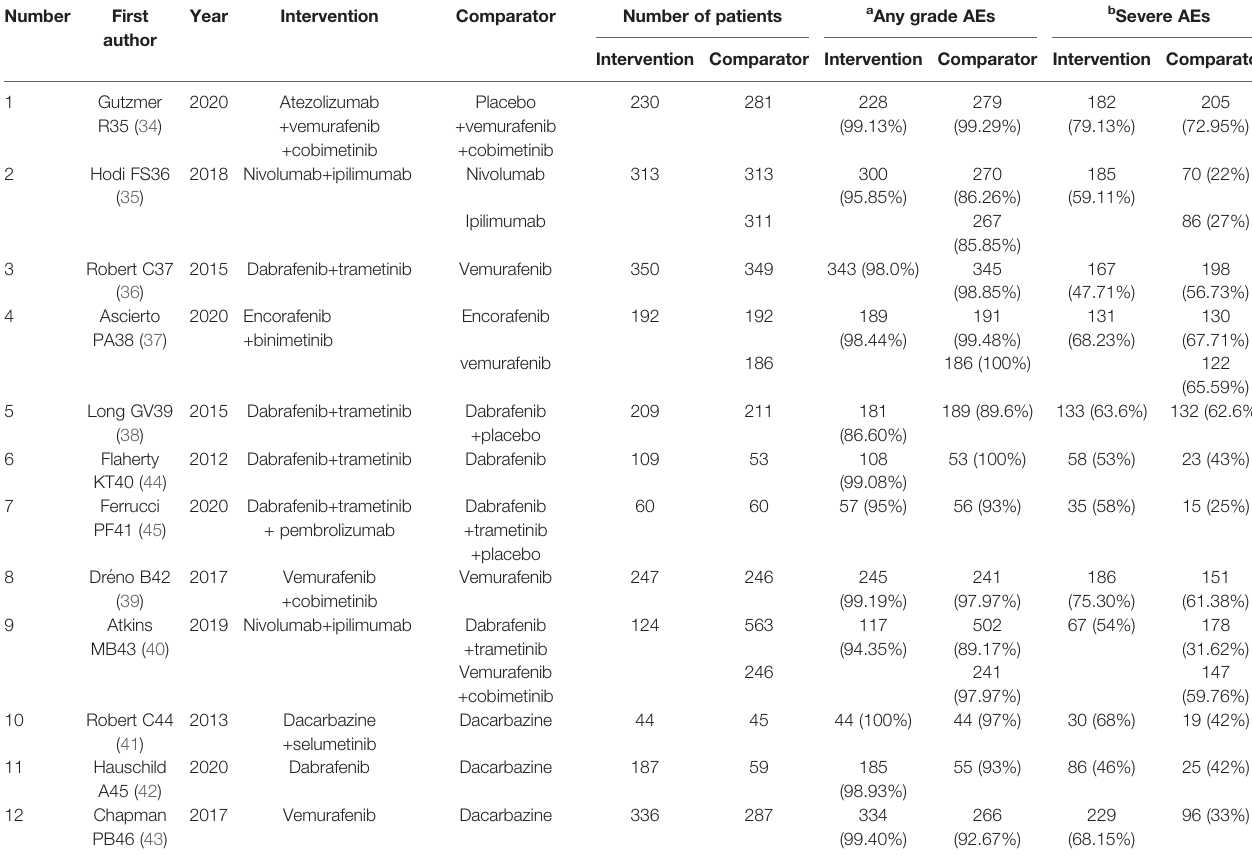
TABLE 1 | Characteristics of included randomized controlled trials ( n = 12) and results of the systematic literature